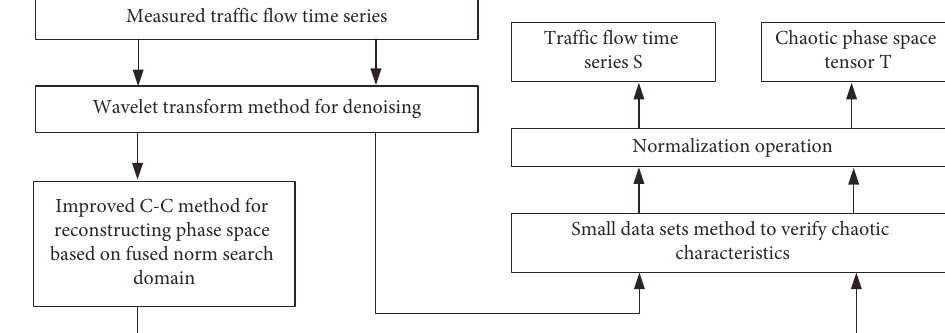
Figure 1: Flowchart of chaotic traffic flow